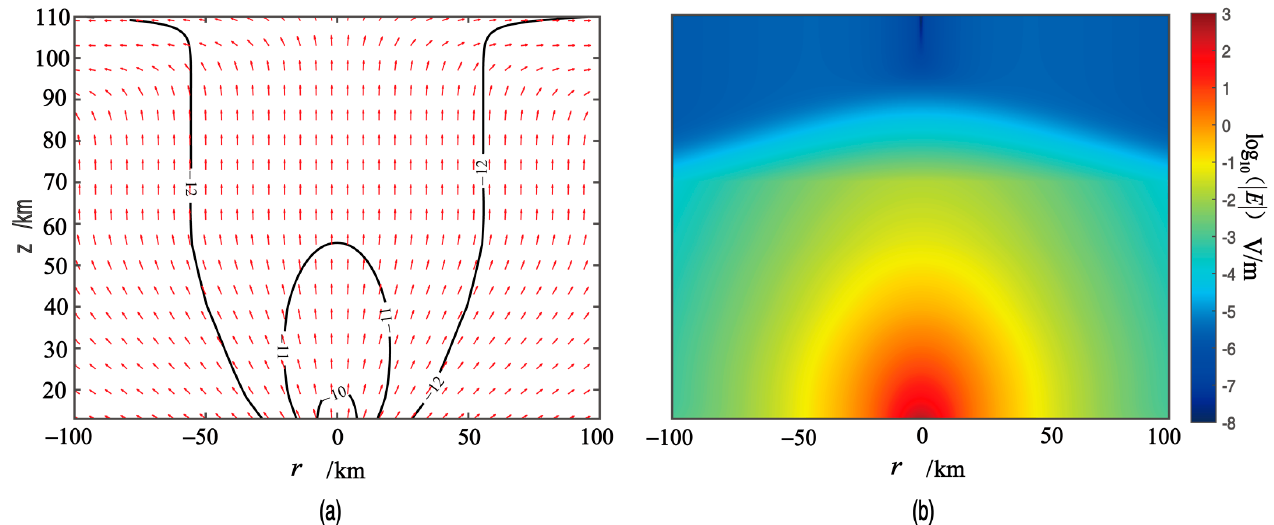
Figure 5. ( a ) Contour diagram of the conduction current intensity caused by a 1-C dipolar charge at 5–10 km. The arrow indicates the flow direction of the current, and the units of the current density are 2 A/m . ( b ) Electric field intensity distribution caused by a dipolar charge at 5–10 km.